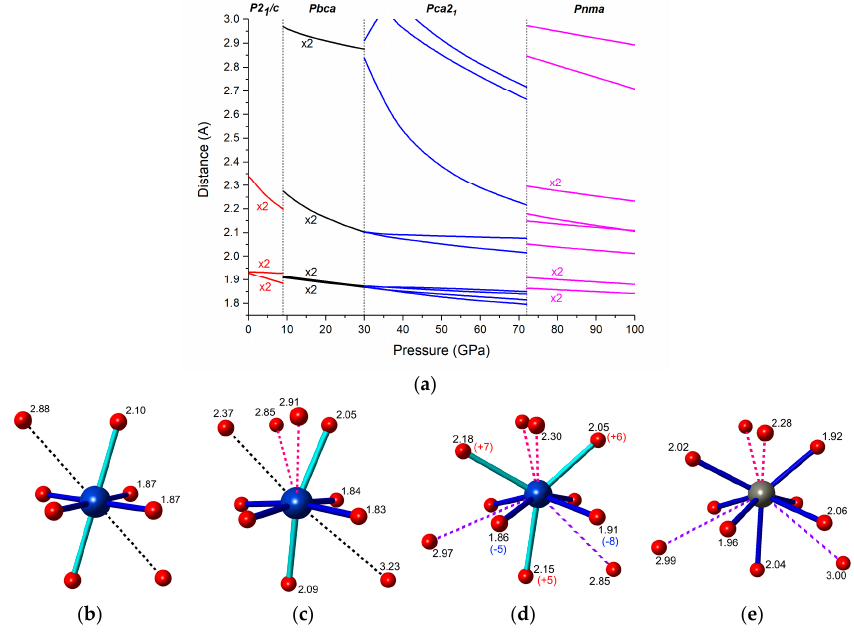
Figure 7. ( a ) Calculated pressure dependence of the Cu-F distances in the high-pressure polymorphs of CuF 2 . The coordination of the Cu 2+ cation in ( b ) Pbca at 30 GPa; ( c ) Pca2 1 at 50 GPa; and ( d ) Pnma at 72 GPa; together with ( e ) the Zn 2+ coordination in the Pnma phase of ZnF 2 optimized at 72 GPa. Distances are given in Å; numbers in parentheses indicate the percentage difference between the Cu-F and Zn-F distances in the Pnma polymorphs.